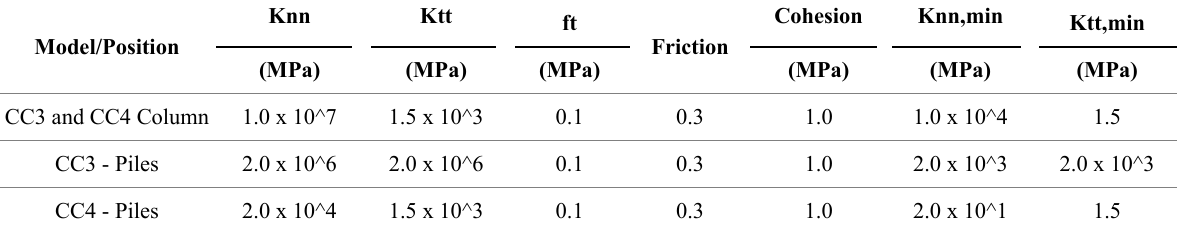
Table 1. Mechanical properties and position of interface elements of models CC3 and